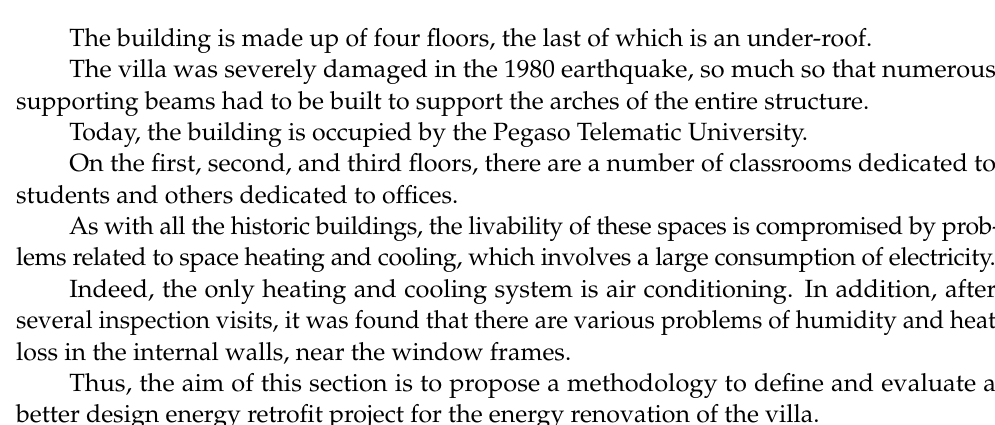
Figure 3. Internal areas Villa